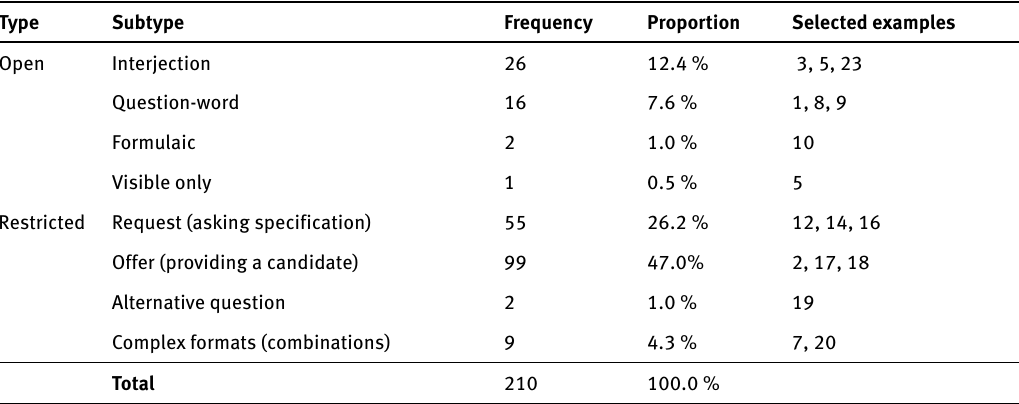
Table 3: Types of repair initiators and their frequency in the Siwu